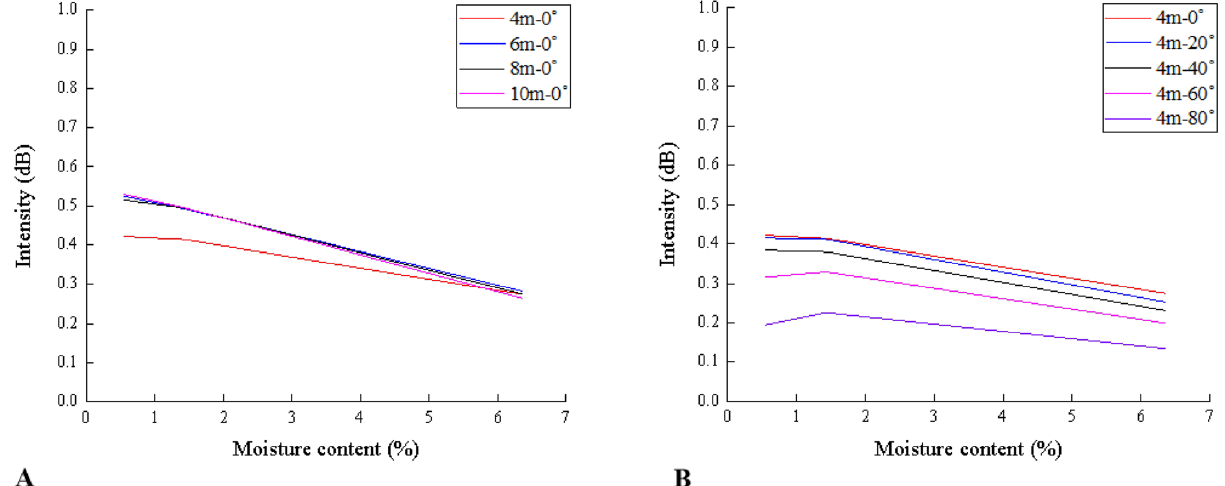
Figure 5. Relationships between the laser reflection intensity and the moisture content of the specimens with the normal incidence angle ( A ) and with the distance of 4 m ( B ) (Software: Riscan pro 2.1; riscan-pro.software. informer.com; Origin 2021b; https:// www. origi nlab. com/ index. aspx? go= PRODU CTS/ Origin).